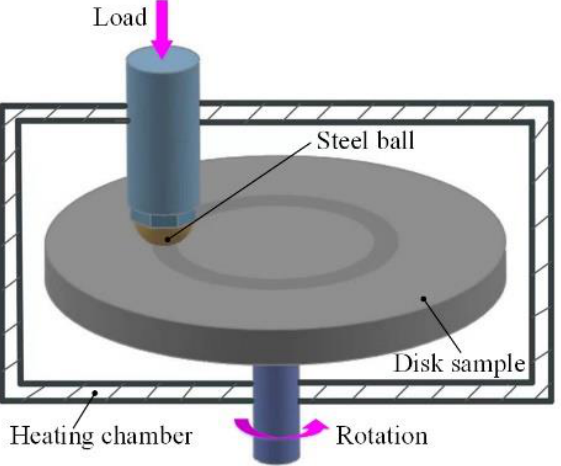
Figure 2. Schematic diagram of the rotating ball-on-disk contact configuration.